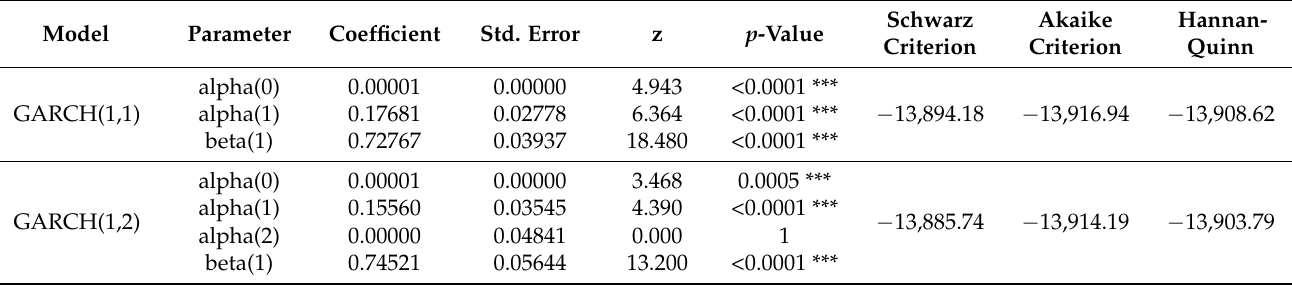
Table A3. Parameters and statistics of GARCH models in the case of